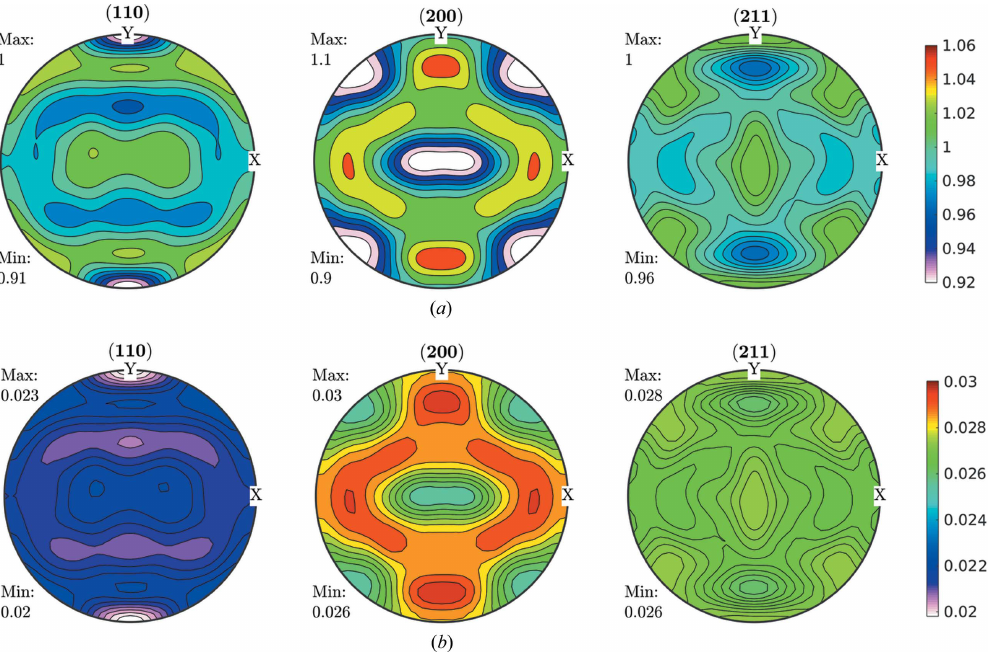
Figure 4 Recalculated GPF for the FWHM shown in Fig. 3, ( a ) normalized, ( b ) divided by the normalization factor ( (cid:6) ) to obtain a real FWHM versus PF orientation. The consistencies, both qualitative and quantitative, observed between the measured and reconstructed GPFs were used as a rule of thumb criteria for checking the viability to represent the FWHM as a crystalline orientation-dependent